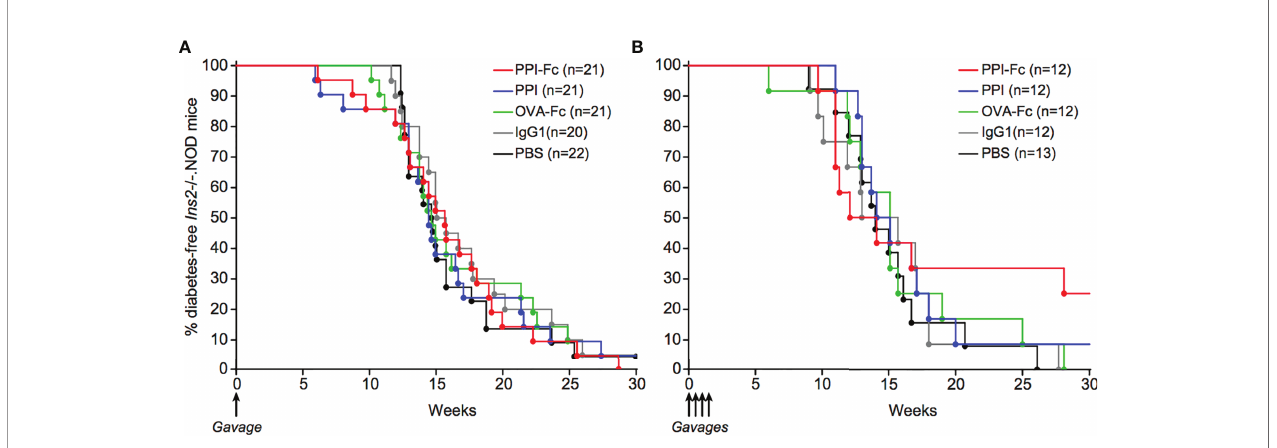
FIGURE 6 | Oral PPI-Fc partially delays diabetes onset in polyclonal Ins2 -/- .NOD mice. Diabetes incidence in Ins2 -/- .NOD mice after oral administration of 50 µg PPI- Fc (red) or equimolar amounts of PPI (blue), OVA-Fc (green), IgG1 (grey) or PBS (black) at day 1 (A) or day 1, 4, 7 and 10 of life ( B ; p=0.13 between PPI-Fc and control groups by log-rank